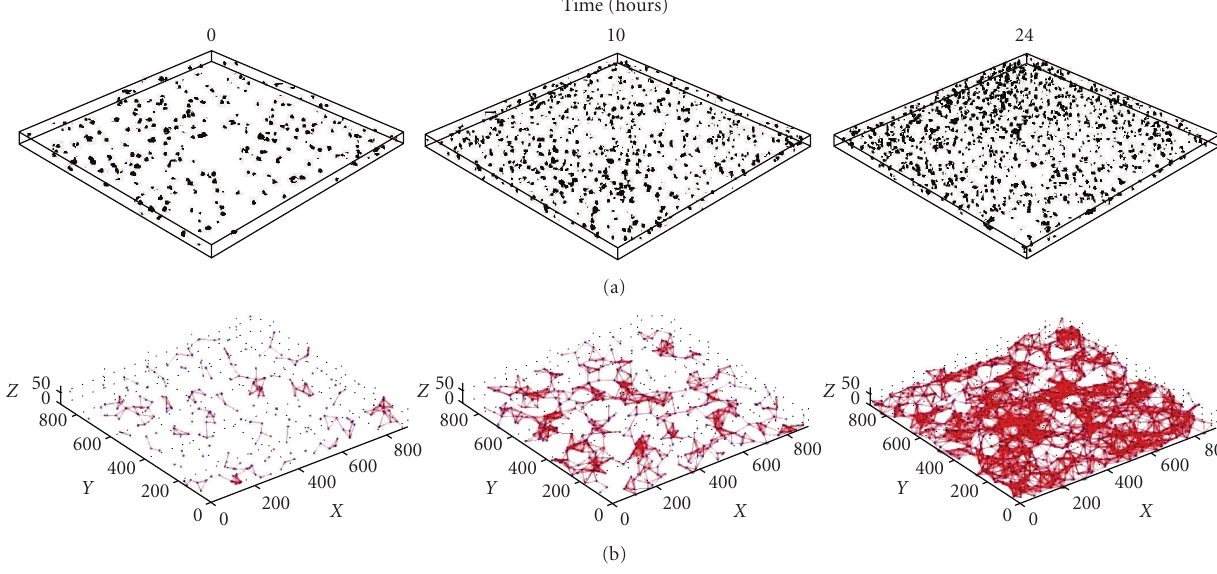
Figure 4: Graph theory applied to fluorescent confocal z-stacks from the 1 × 10 6 cells/mL time course to generate distance dependent cell- graphs. (a) 3D representations of fluorescent image z-stacks of 1 × 10 6 cell densities. (b) 3D cell-graph generated from fluorescent image z-stacks of 1 × 10 6 cell